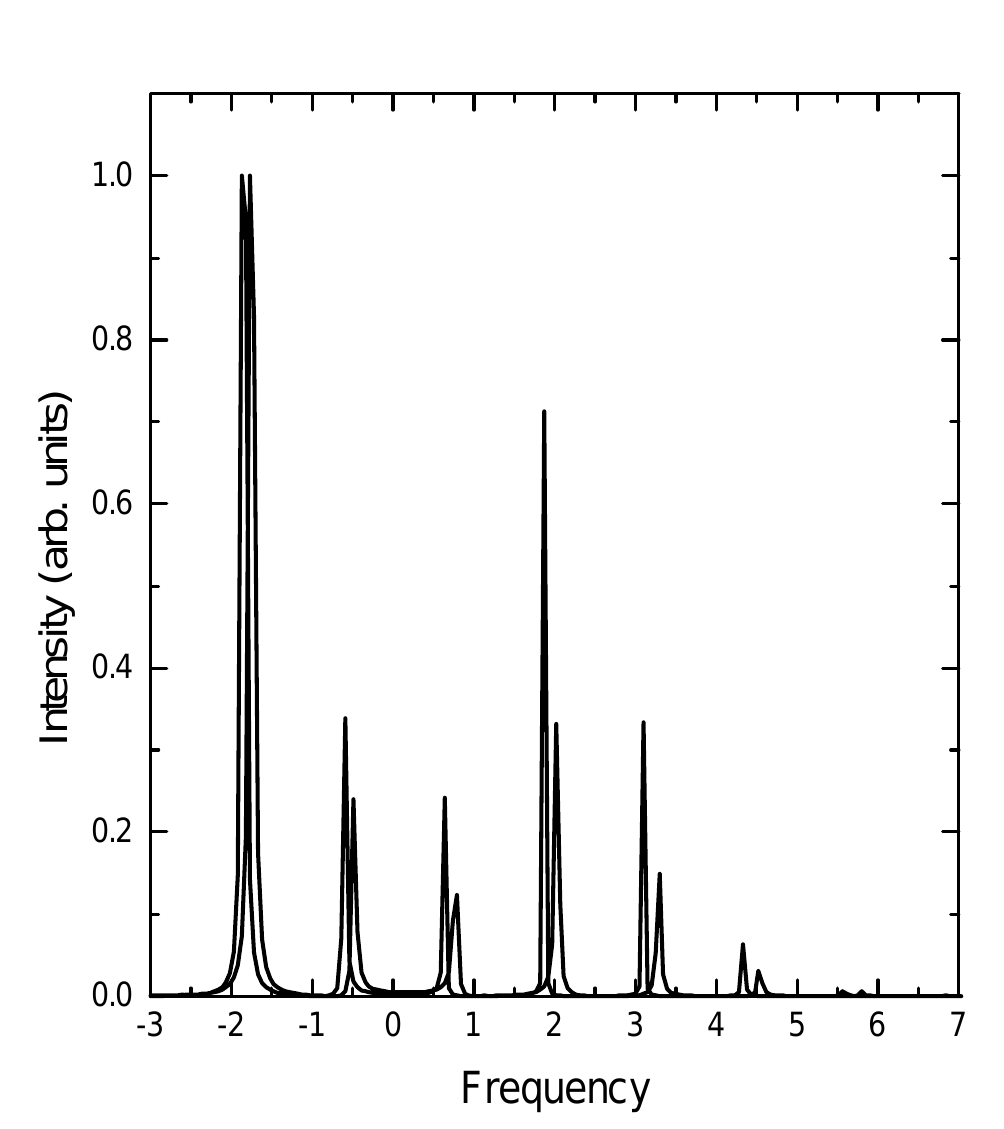
Fig.2: Raman excitation profile for the fundamental transition. (Figure conventions are the same as